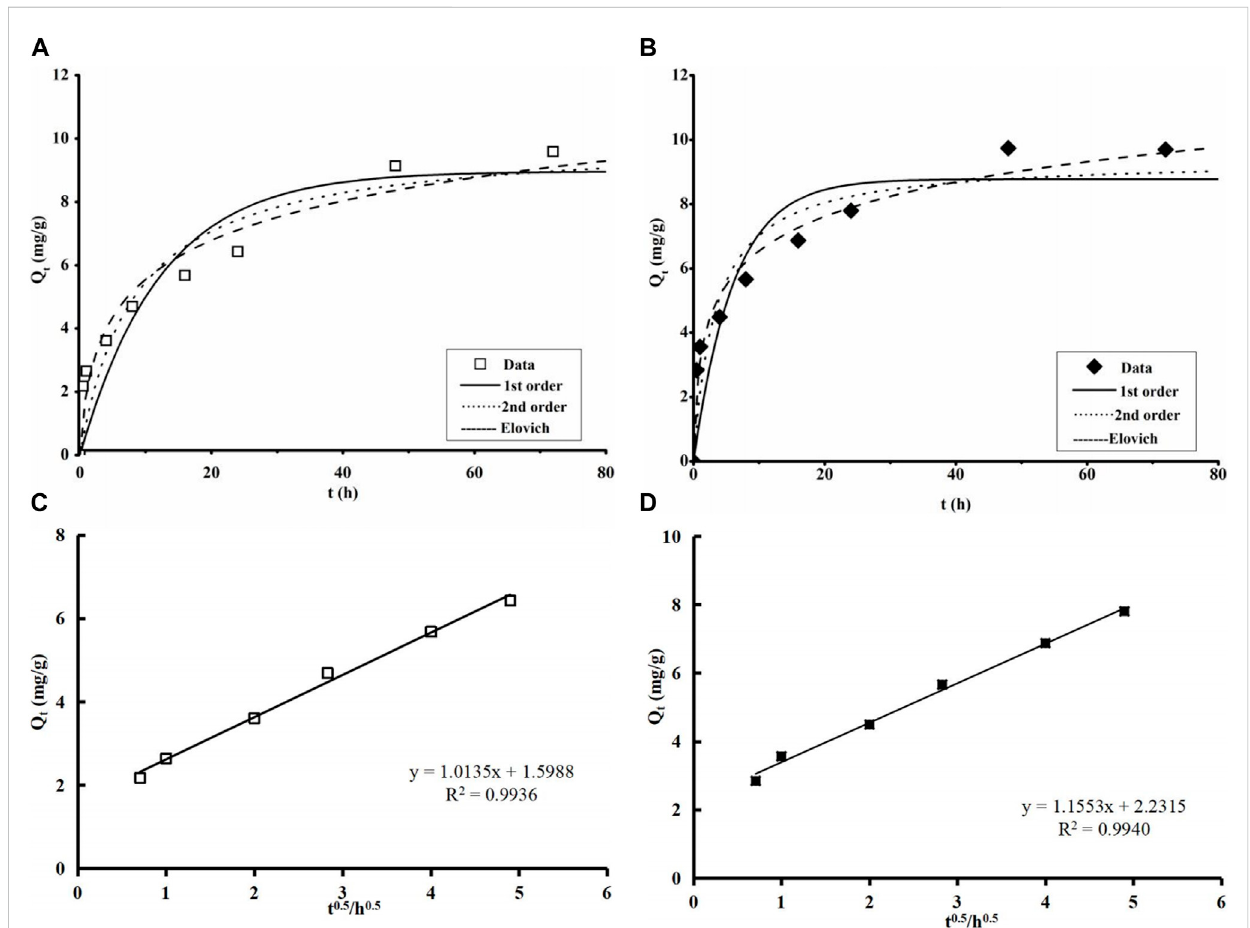
Adsorption kinetics data and modeling for MB adsorption by the two biochar samples: (A) KLN-TWBC and (B) MMT-TWBC full adsorption; (C) KLN- TWBC and (D) MMT-TWBC pre-equilibrium adsorption versus square root of time (Initial MB concentration of 20 mg/L, temperature 25 ° C ± 0.5 °